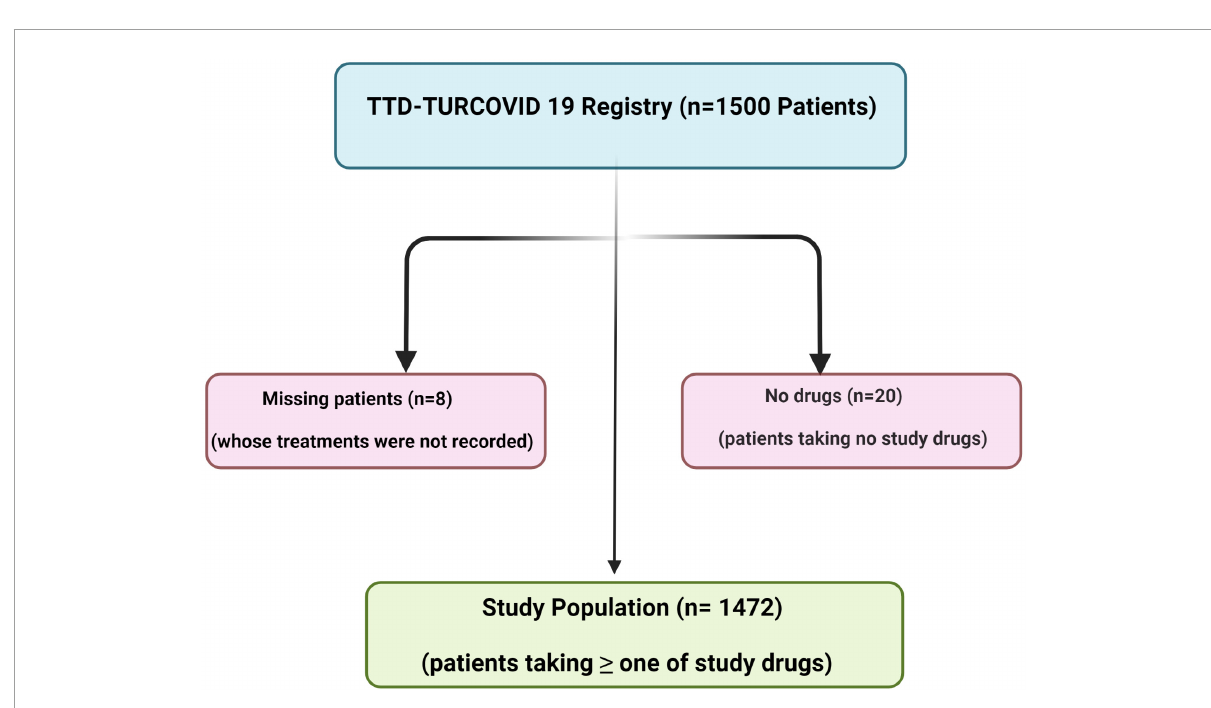
FIGURE2 The enrollment of the study